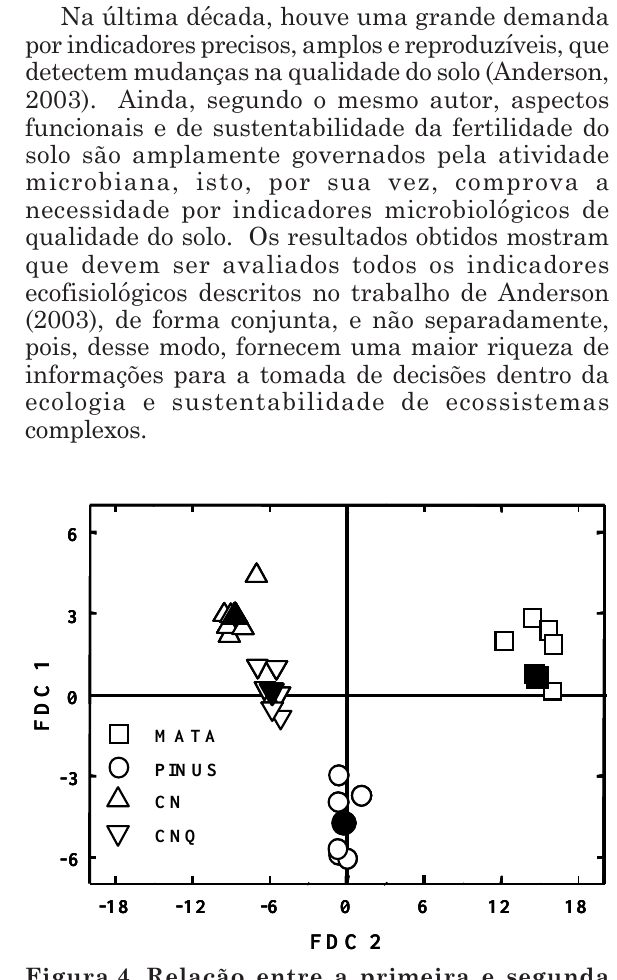
Figura 4. Relação entre a primeira e segunda função discriminante canônica (FDC1 e FDC2) sobre os coeficientes canônicos homogeneizados (CCH) de carbono da biomassa microbiana, respiração basal, carbono orgânico total e quociente metabólico, em quatro tratamentos de manejo de solo na região de Lages